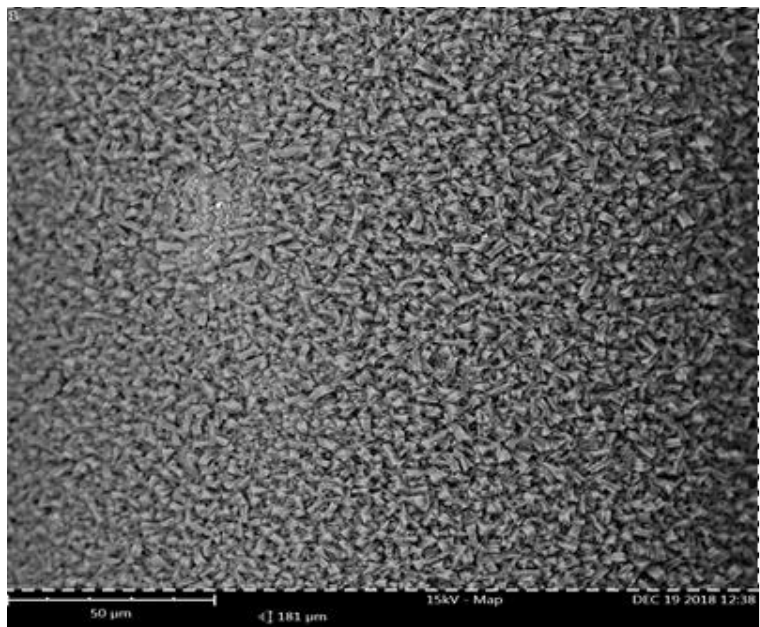
Fig.5 . SEM image of Metal-organic framework on copper nanoarrays nanocomposite